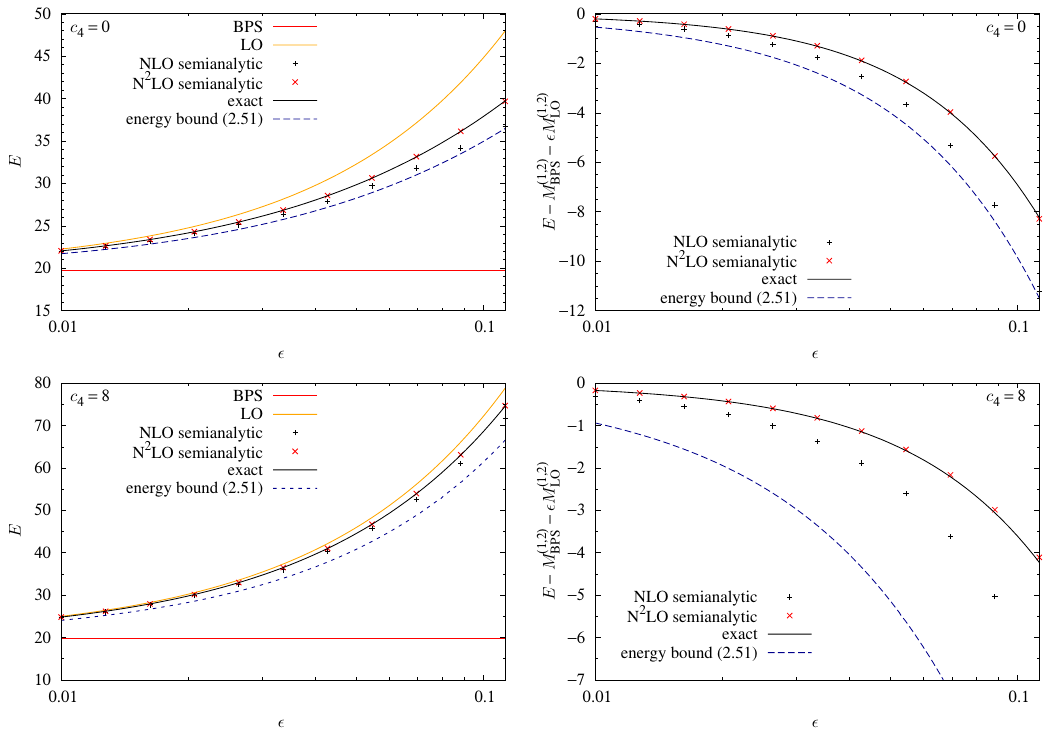
Figure 3 . The mass of the Skyrmion in the perturbative (cid:15) -expansion as a function of (cid:15) on a logarithmic scale. The red solid line represents the BPS bound, the orange solid line is the LO correction to the energy, the black pluses are NLO corrections and finally the red crosses are N 2 LO corrections. For comparison, the solid black line shows the exact ODE calculation. We also show the energy bound (A.8) with a blue-dashed line. The top row shows the case of c 4 = 0 and the bottom row shows c 4 = 8 . In this figure c 2 = 1 , c 6 = 1 , µ = 1 , m π = 3 , and ( s, p ) = (1 , 2) . 2 The energy for different values of c and µ (with modified values of m and c ) can be 6 π 2 recovered by a scaling argument of length and energy